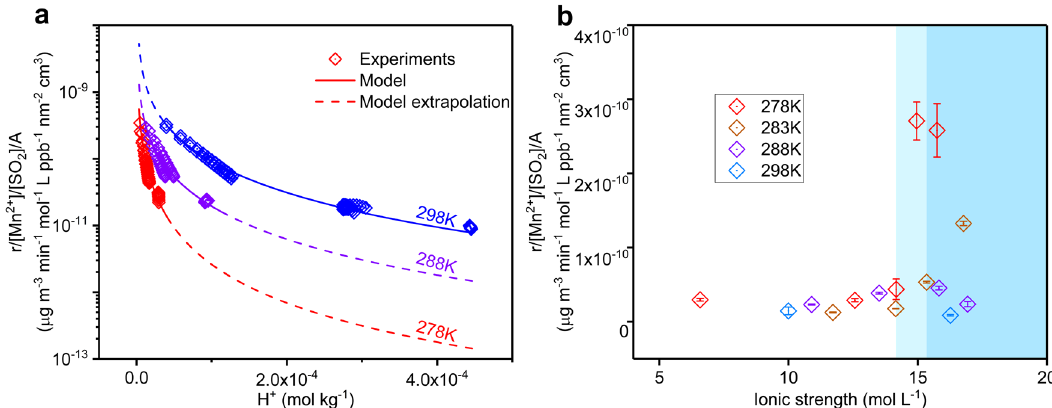
Fig. 3 Temperature and ionic strength impacts on Mn-catalytic reaction. a Temperature effect on the reaction, sulfate formation rate ( r ) excluding impacts of Mn 2 + concentration, SO 2 mixing ratio and particle surface area concentration ( A ) (see Eqs. (4) and (5)) is shown on the y -axis and the concentration of H + is shown on the x -axis. The blue, violet, and red symbols indicate the experiments conducted at 298, 288, and 278 K, respectively. All of the experiments at 278 K were conducted in >84% relative humidity (RH) conditions, while the experiments at 288 and 298 K were conducted in >80% RH. b Ionic strength effect on the reaction; the light blue shaded area indicates RH ranging from 82 to 84%; the blue shaded area indicates RH < 82%. Error bars represent standard